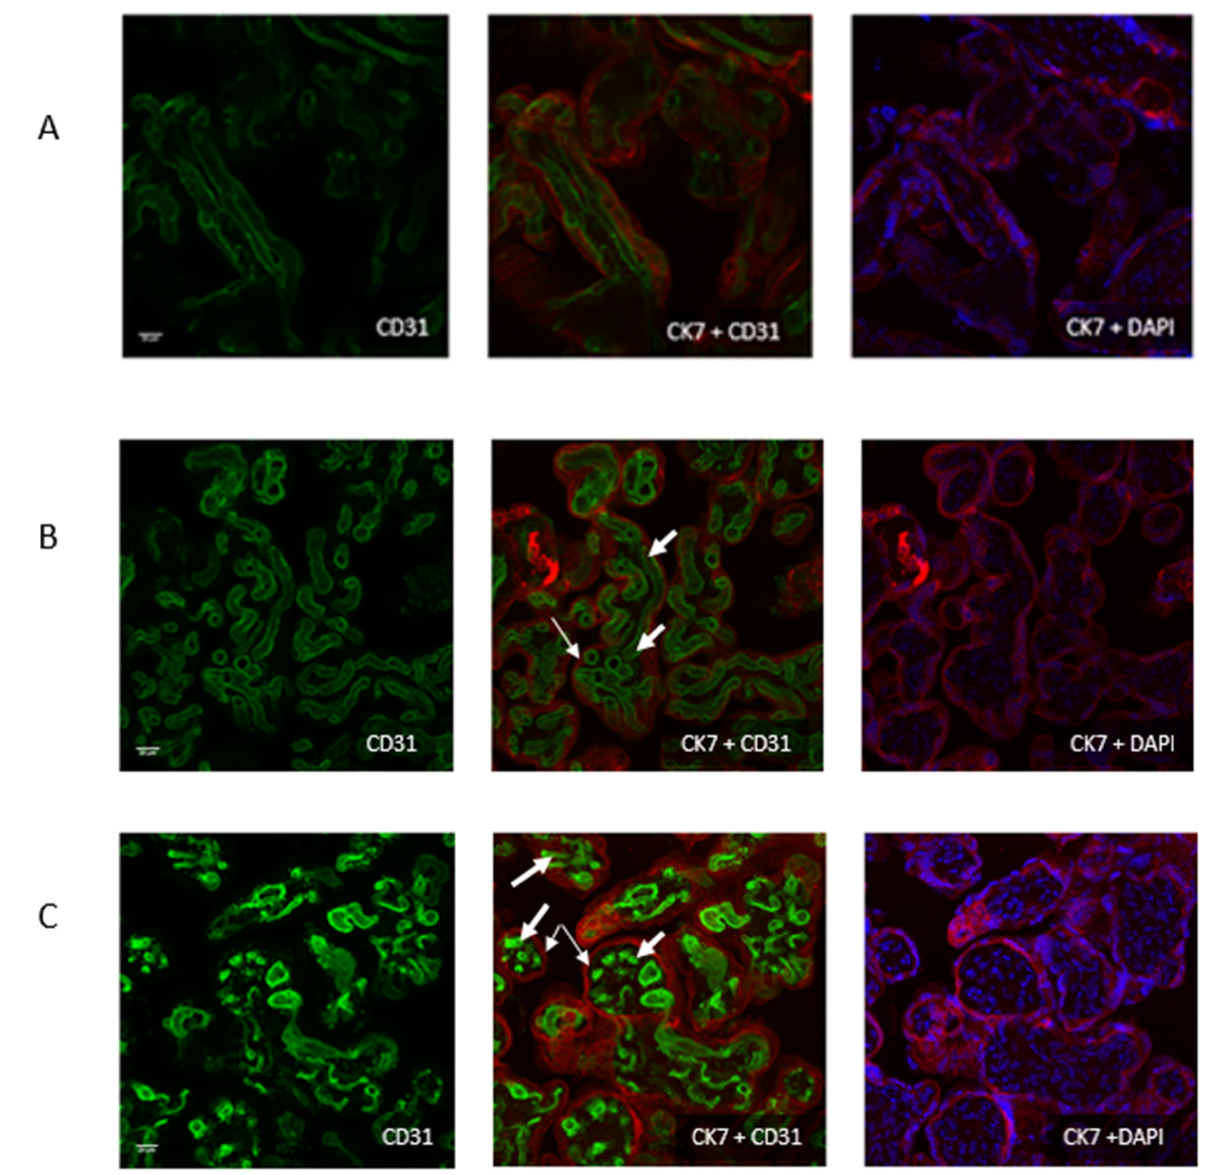
Figure 4. Acquisitions were performed on 240 min-perfused placentas with a Leica SP8 confocal microscope (40X/1.3) in immersion. Anti-CD31 antibodies were used for endothelial cells and thus cytotrophoblast labelling (thin arrows), anti-CK7 antibodies for syncytiotrophoblast labelling (thick arrows), and nuclei were stained with DAPI. ( A ) control, ( B ) after G perfusion, ( C ) after R perfusion.